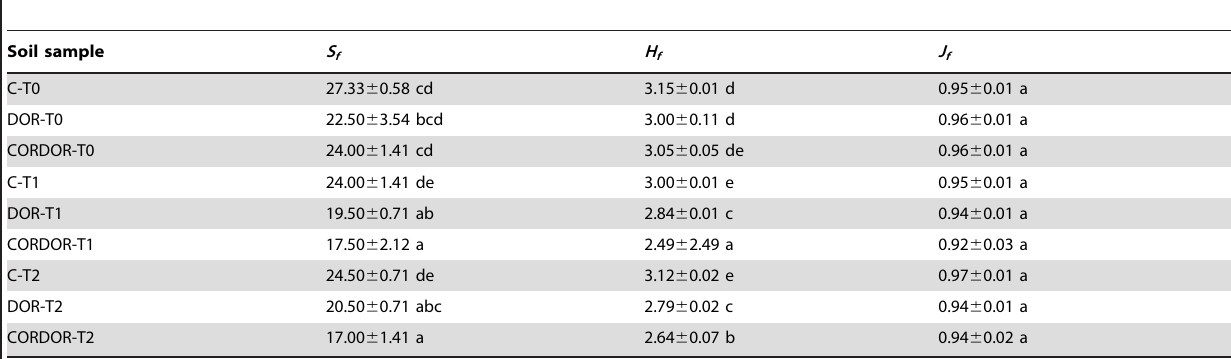
Table 3. Functional microbial diversity characteristics (mean 6 standard deviation) obtained from unamended soil (C) and soil amended with untransformed DOR (DOR) or C. floccosa –transformed DOR (CORDOR) at 0 (T0), 30 (T1) and 60 (T2) days.